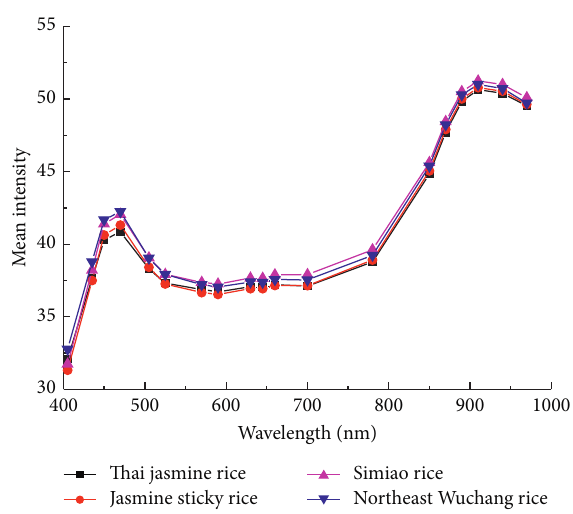
Figure 3: Average reflection spectra from the multispectral images of Thai jasmine rice and three other varieties of